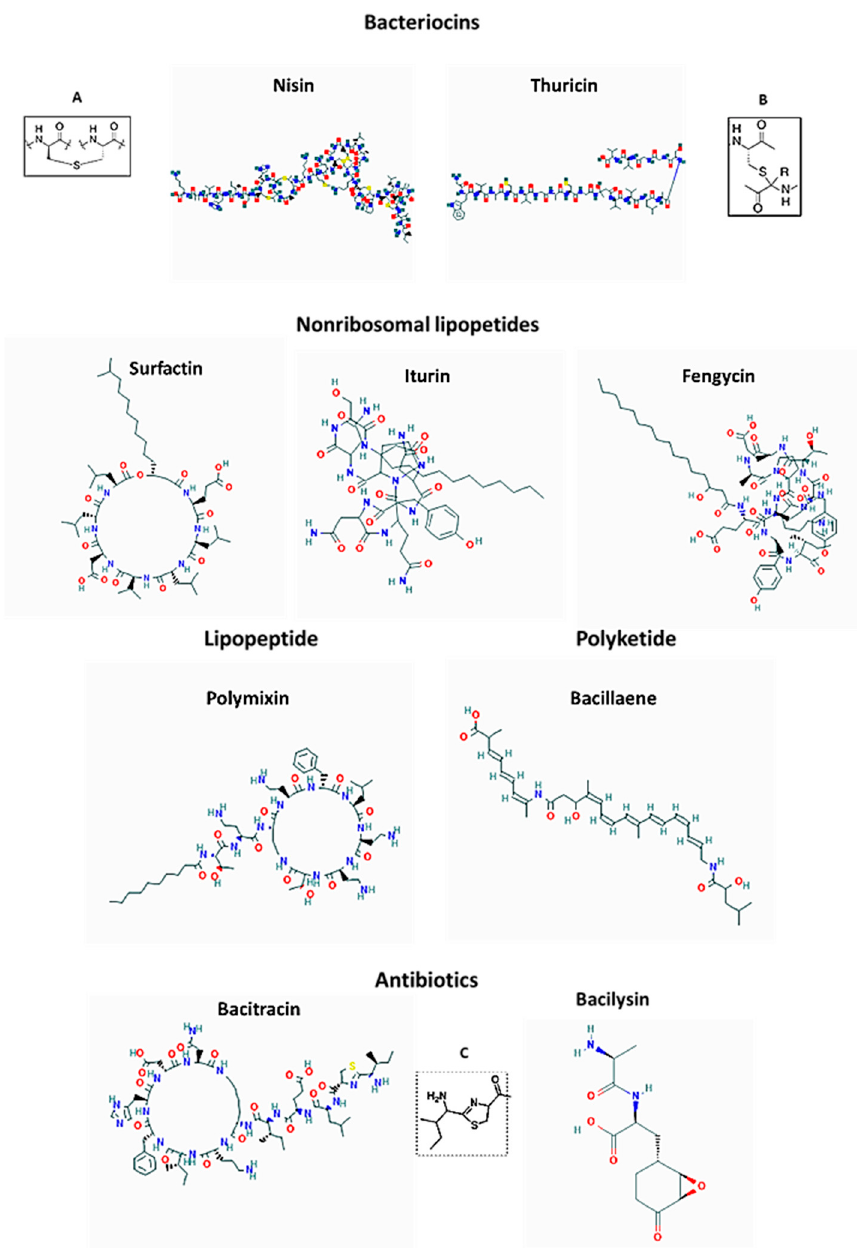
Figure 3. Structures of bacteriocins, antibiotics, lipopetides and polyketide of Bacillus spp. Inserts present; ( A ) lanthionine ring, ( B ) sactibiotic ring, ( C ) thiazoline ring.